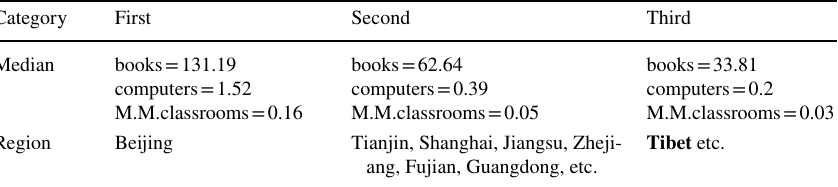
Table 12 Clustering of teaching assets per student (senior high school) Category